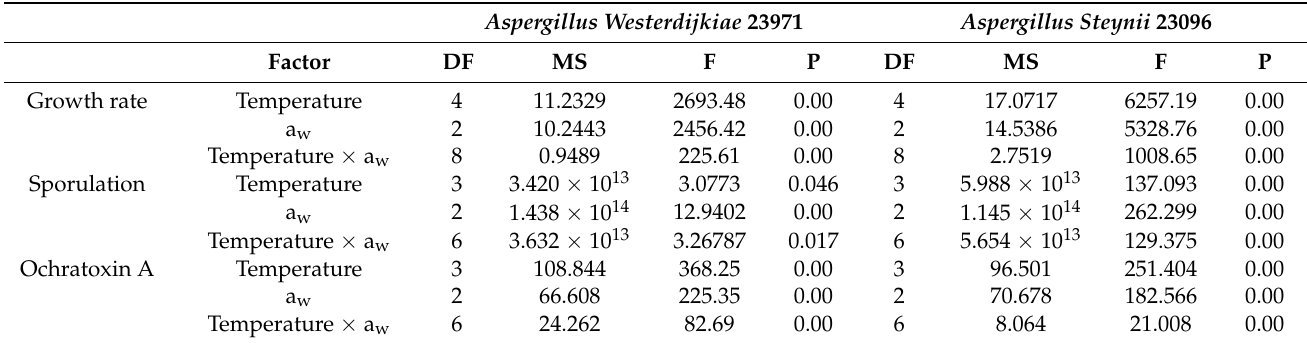
Table 1. Variance analysis of the influence of temperature, a w and their interaction on growth rate, spore production, and ochratoxin A production of A. westerdijkiae and A. steynii . Aspergillus Westerdijkiae 23971